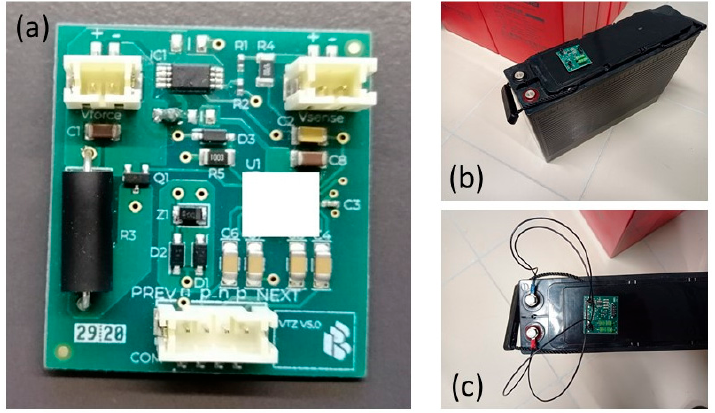
Figure 2. Images of the ( a ) VTZ sensor and ( b , c ) integration of the sensor in a 12 V lead–acid battery block.